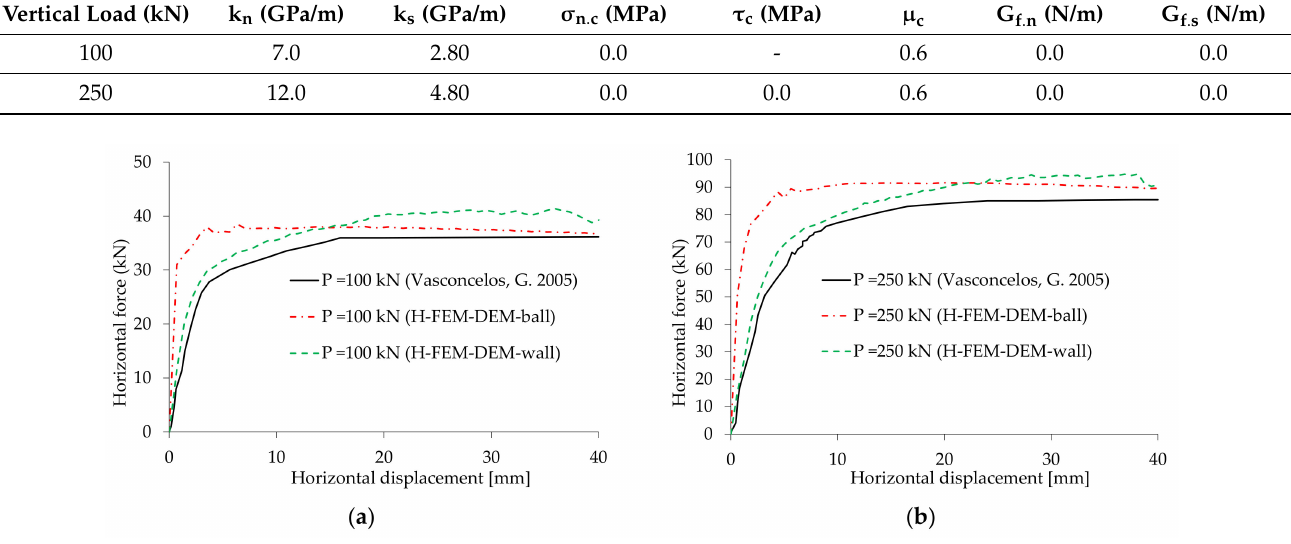
Figure 12. Horizontal force displacement relationship for dry wall monotonic shear tests; comparison with the experimental results adapted from [20]: ( a ) 100 kN pre-compression vertical load; ( b ) 250 kN pre-compression vertical